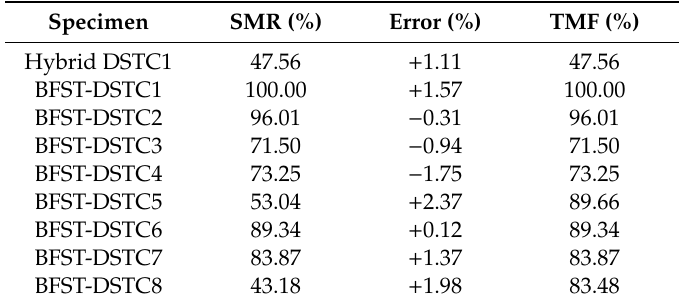
Table 4. TMF, SMR, and error for the outer tubes.